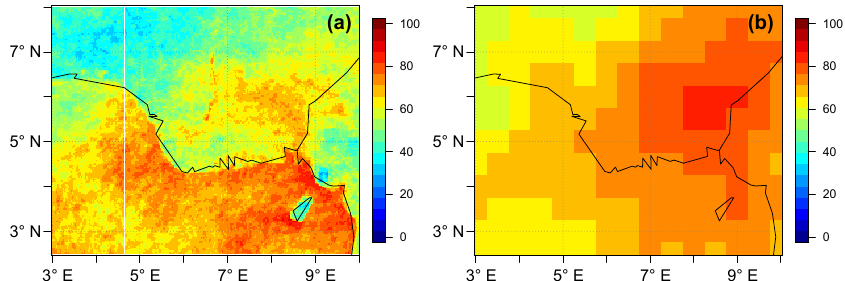
Figure 5. Fractional cloud cover (%) observed from (a) the geostationary MSG3 and (b) the sun-synchronous Aqua/AIRS, averaged over TP15 around the time of VNF observation (approx. 01:00UTC).